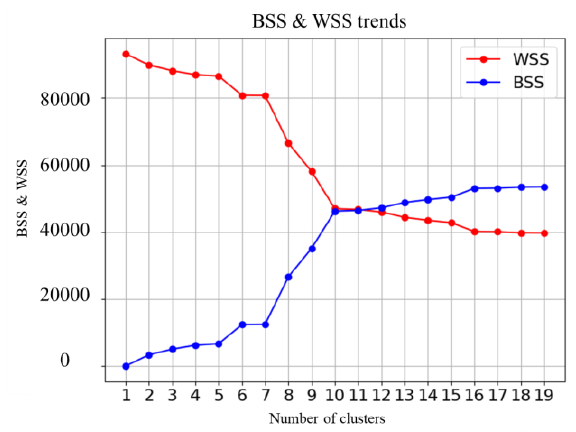
Figure 10 . BSS WSS diagram of the hierarchical clustering on Milan set